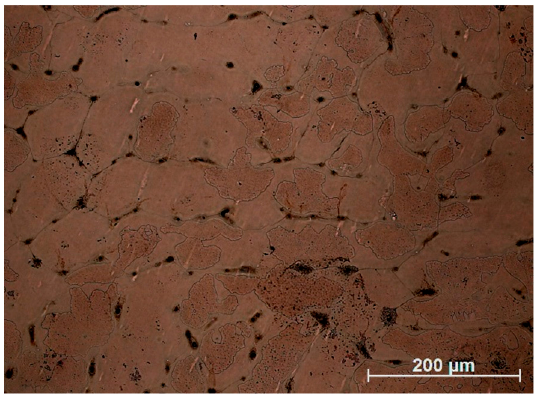
Figure 3. Microstructure of Cu–2Ni–1Si, initial state. Cooling rate 2.2 °C s − 1 .